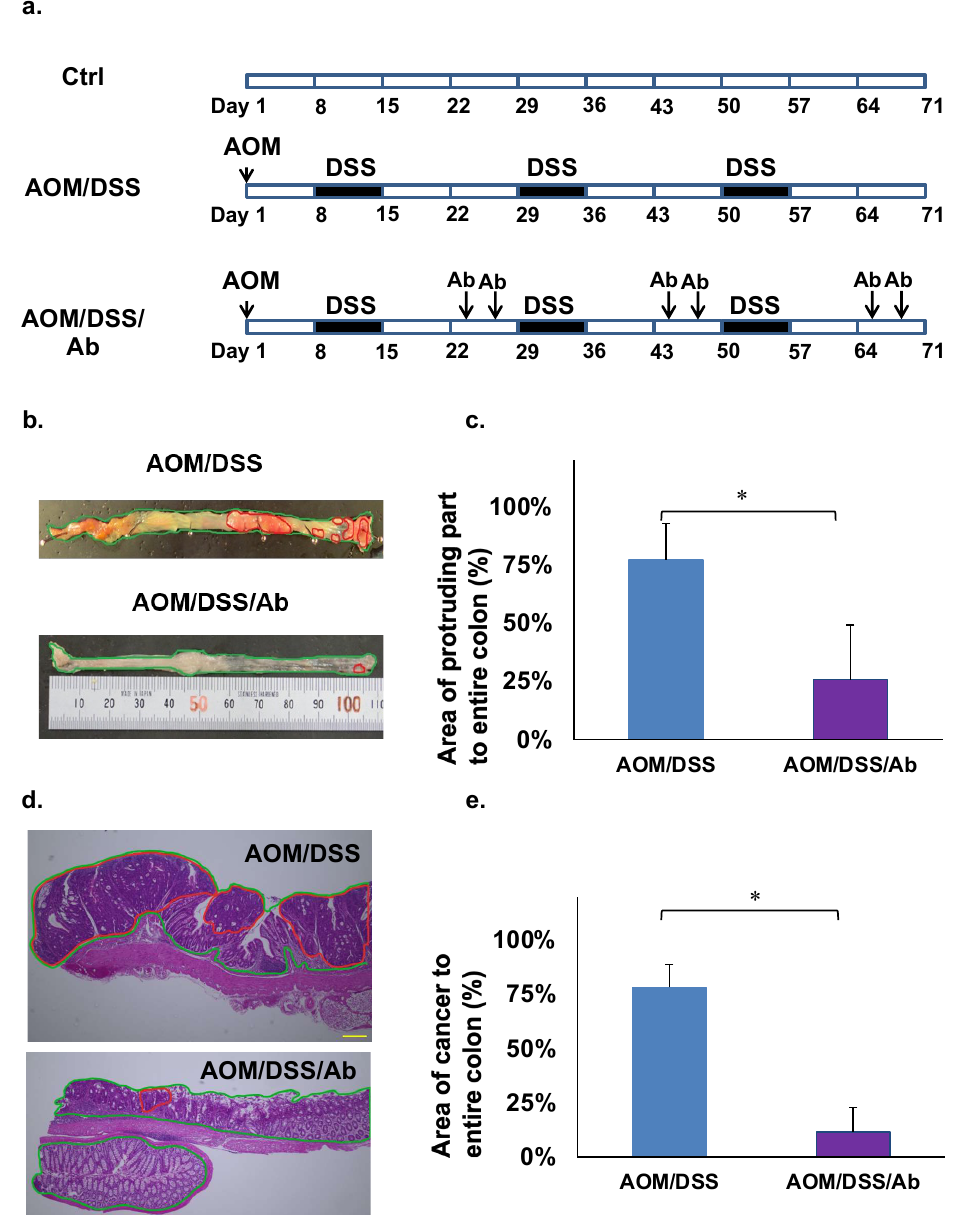
Figure 1. Findings of cancer associated with colitis in mouse models. ( a ) Induction of colitis-associated cancer in mice. ( b ) Macroscopic findings of colon, AOM/DSS (above), AOM/DSS/Ab (below). The areas highlighted by red circles indicate tumor-like lesions. ( c ) Comparison of protruding areas between AOM/DSS and AOM/DSS/Ab groups. ( d ) Colon cancer tissues stained with HE. AOM/DSS (above), AOM/DSS/Ab (below); The areas highlighted by red circles indicate lesions of adenocarcinoma. Scale bars represent 50 µm. ( e ) Comparison of adenocarcinoma areas between AOM/DSS and AOM/DSS/Ab groups. Ab, Infliximab; AOM, azoxymethane; DSS, dextran sodium sulfate; AOM/DSS, mice administered with AOM and DSS; AOM/DSS/Ab, mice administered with AOM, DSS, and Infliximab; Ctrl, control; HE, hematoxylin and eosin. ↓ Intraperitoneal administration. * p < 0.01.